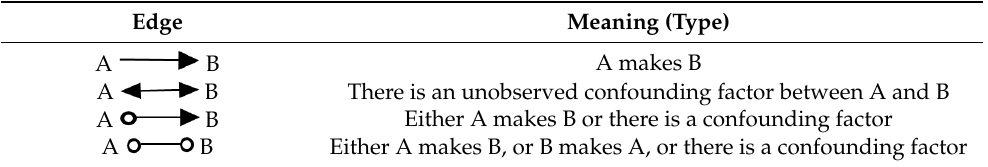
Table 1. Types of edges in causal graphs and their meanings.